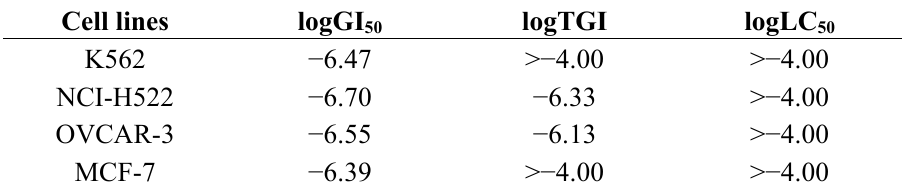
Table 2. Inhibition of in vitro tumor cell growth by compound 1 .